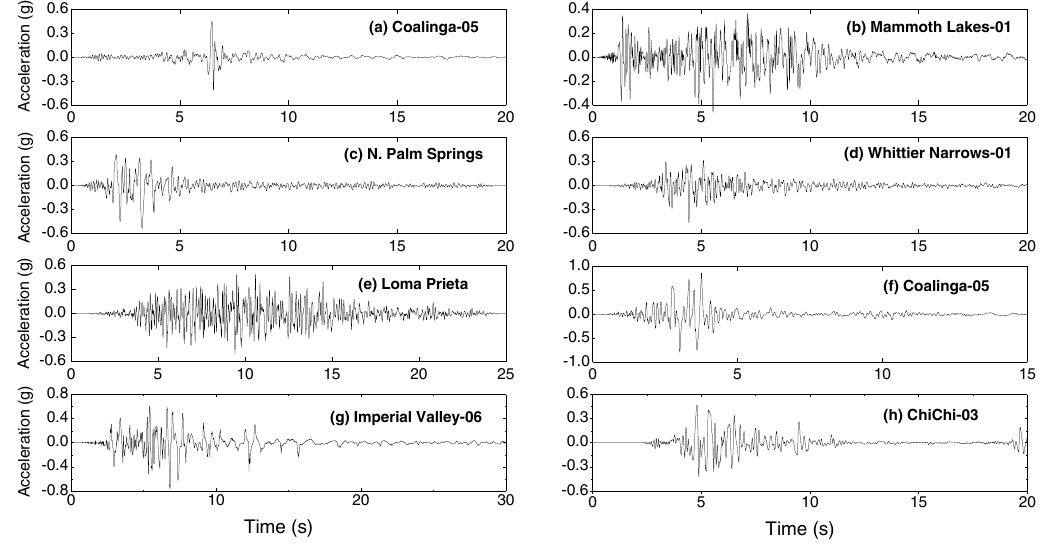
Figure 12. Eight time history recommendations for Chiayi (site d) with DSHA calculations and the NGA strong-motion database.